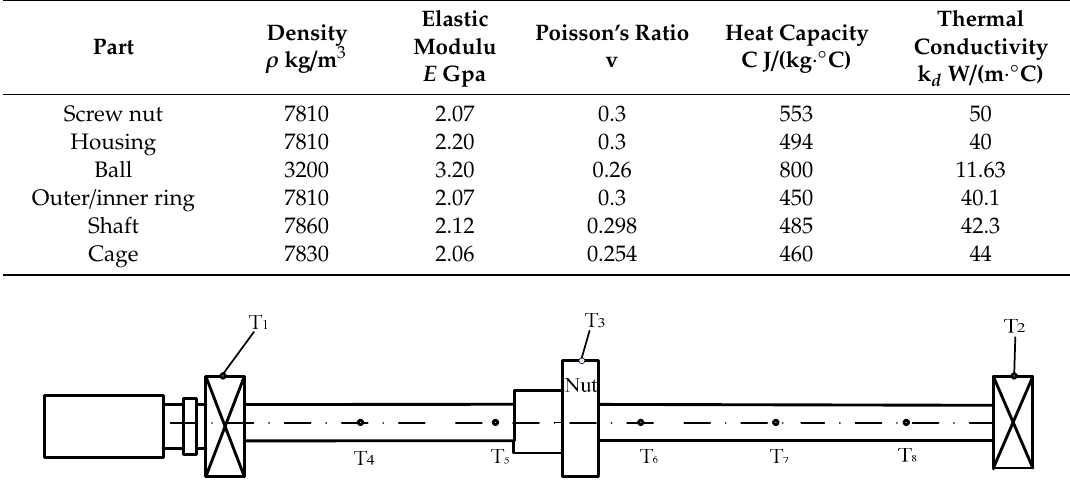
Table 1. Material properties on parts.